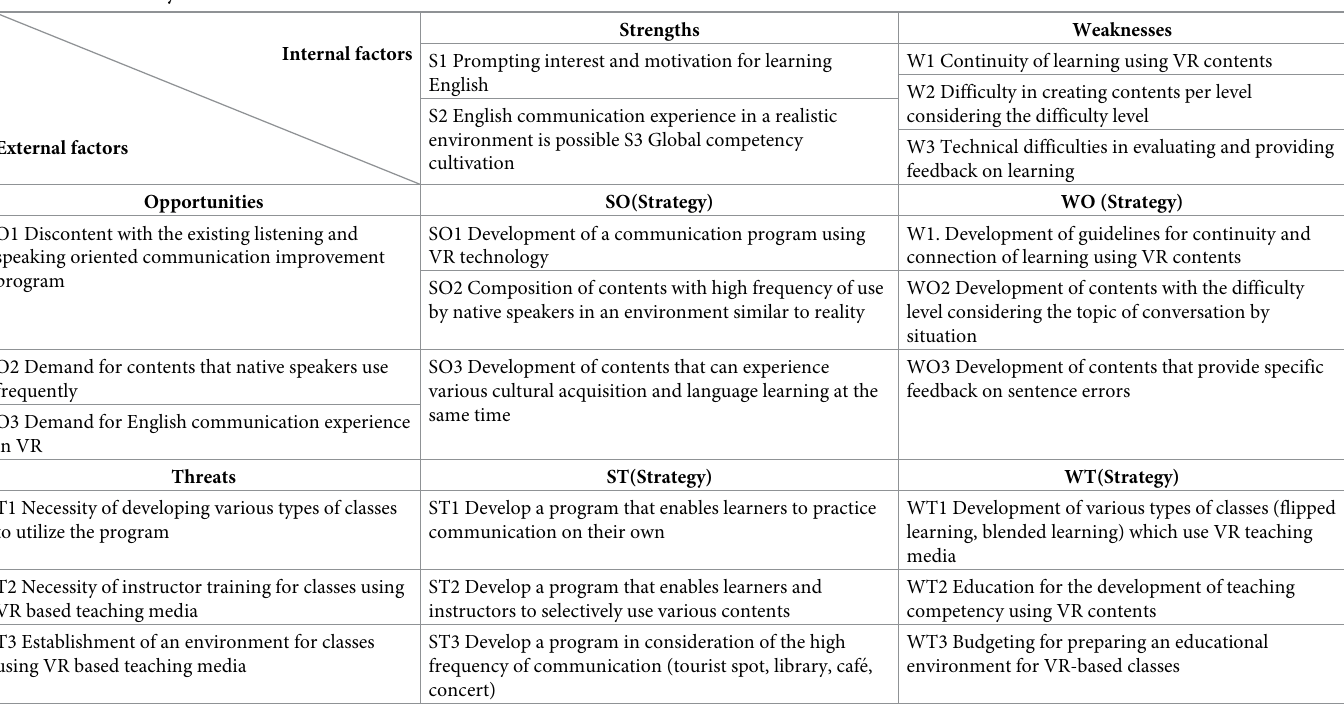
Table 9. SWOT analysis